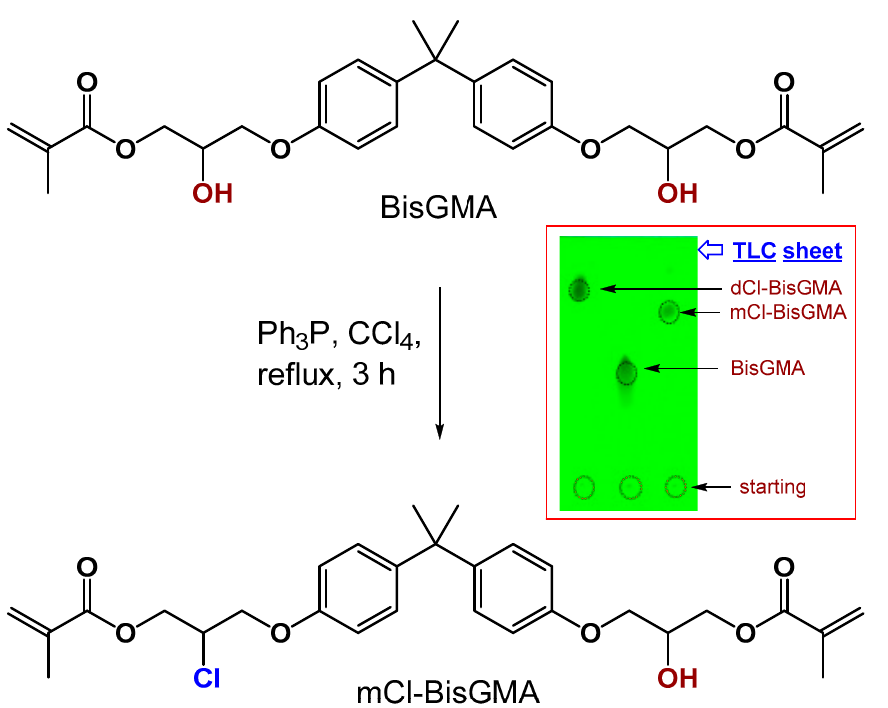
Figure 1. Synthesis of mCl-BisGMA monomer. Inset shows the mobility of dCl-BisGMA, mCl- BisGMA, and BisGMA monomers’ TLC spots using EA/n-H (4:6 v / v ) as a mobile phase. Spots were visualized under UV light.